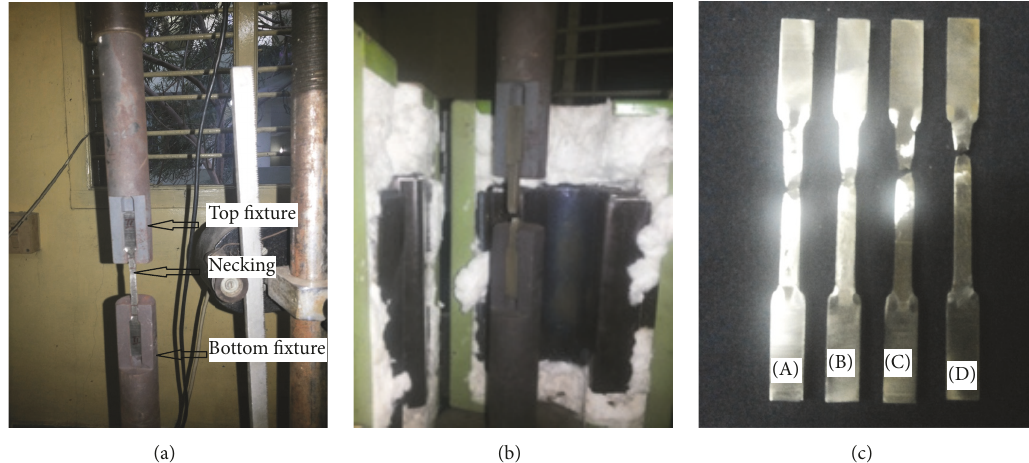
Figure 5: (a) Parent metal showing necking at room temperature. (b) Parent metal at the end of 400 ∘ C test. (c) Tested specimens of the parent metal: (A) room temperature, (B) 200 ∘ C, (C) 400 ∘ C, and (D) 550 ∘ C.